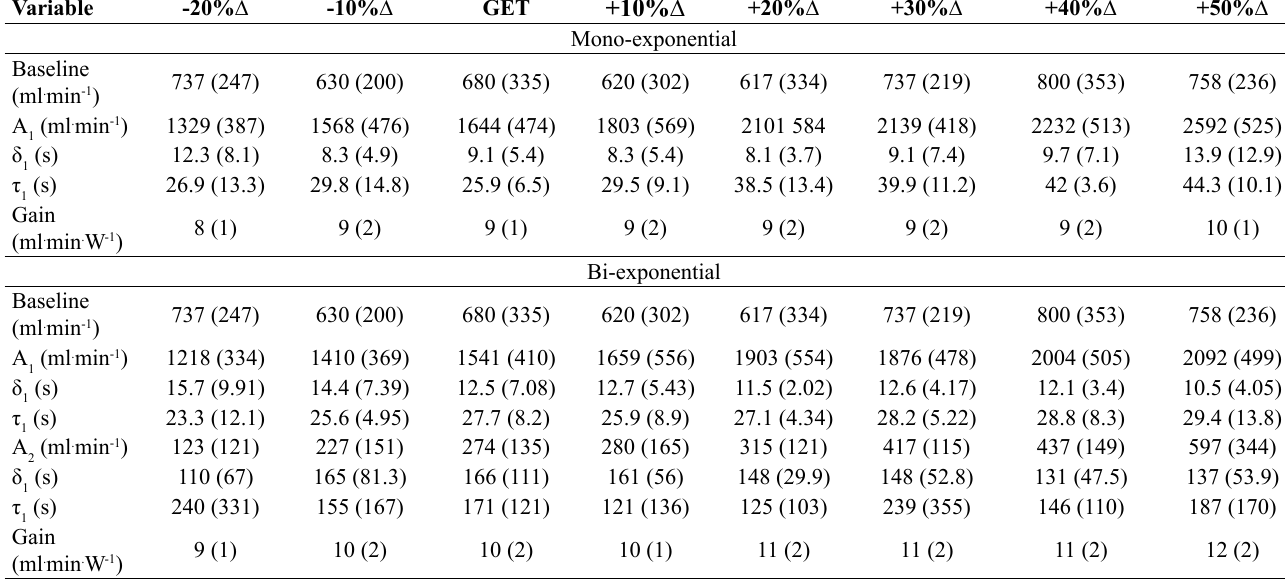
Table 1. Parameters of the oxygen uptake response as a function of exercise intensity for the mono- and bi-exponential model, V̇ O and standard error of the